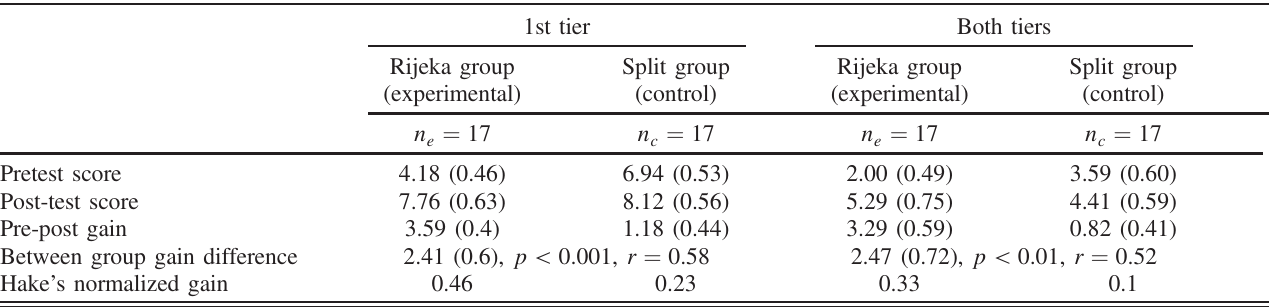
TABLE III. Pretest and post-test average scores and information about gain. Standard errors are given in